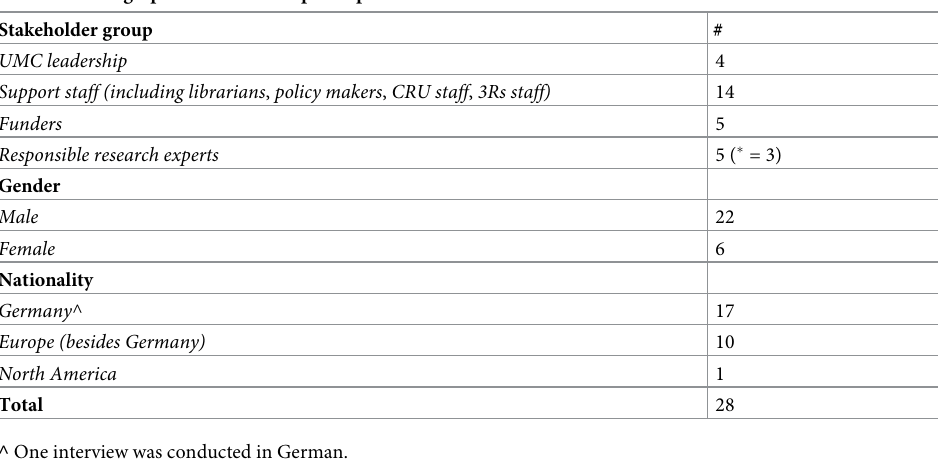
Table 2. Demographics of interview